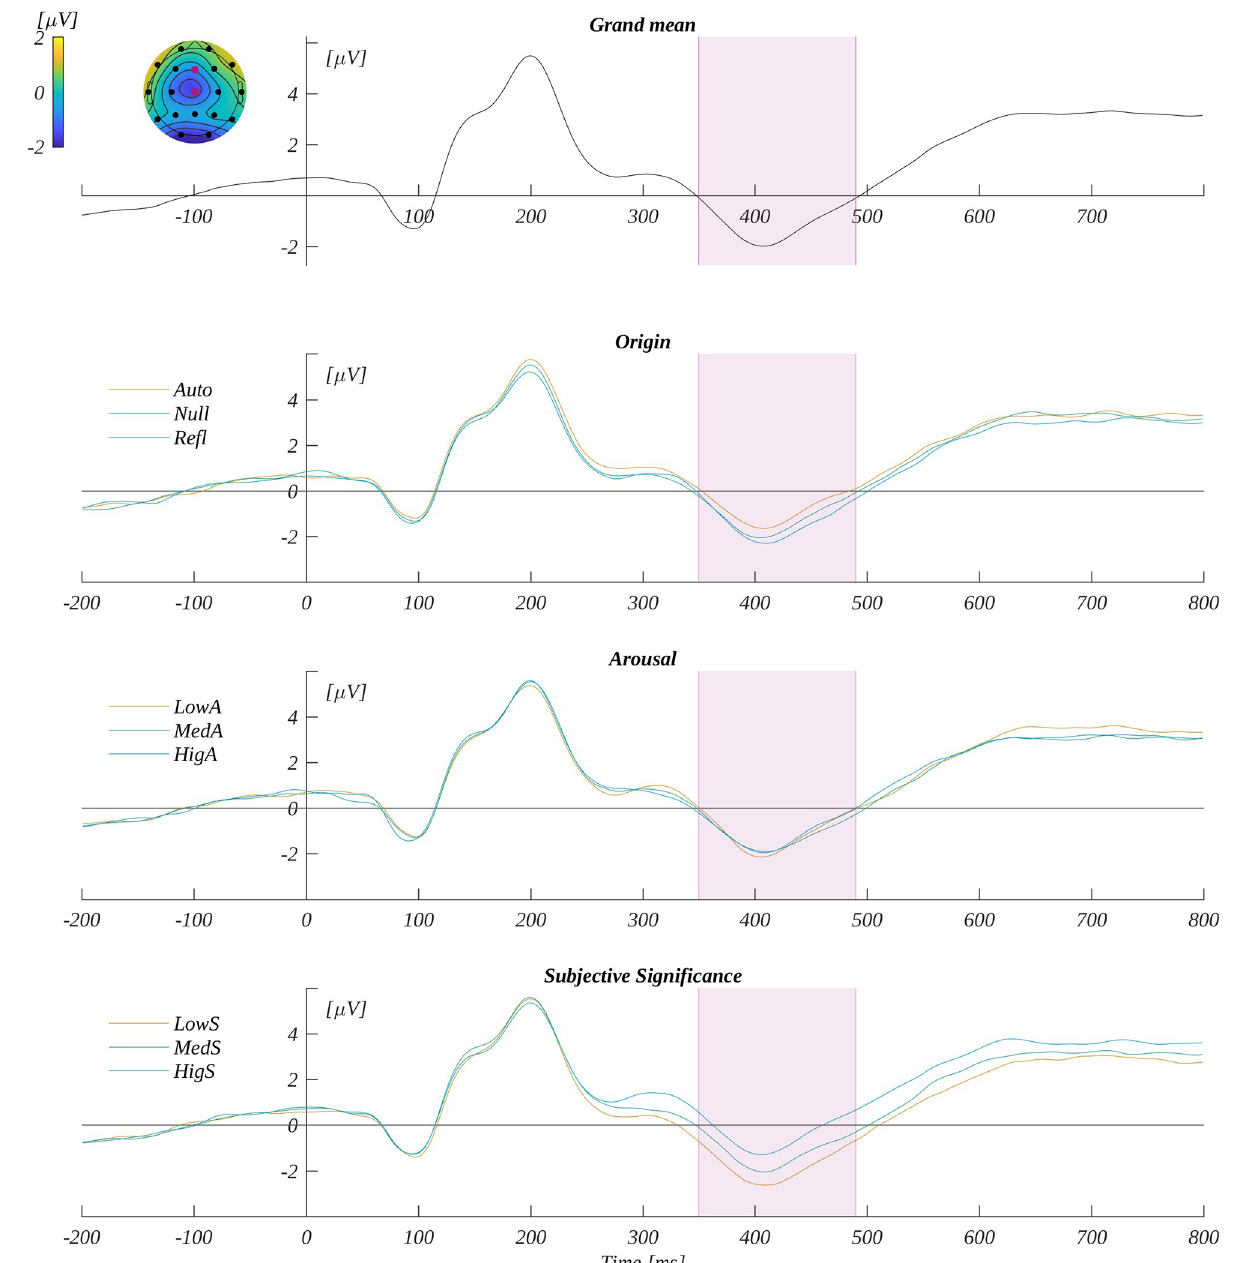
Fig 6. N450 potential. The upper plot: the grand average across electrodes from ROI N450 . The marked time-interval was selected for the N450 analysis. The insert shows the topography of the mean potential from this period with the electrodes forming the ROI N450 marked with pink dots. The three bottom plots are the time courses for ERP averaged across electrodes from ROI N450 for each level of origin, arousal and subjective significance.